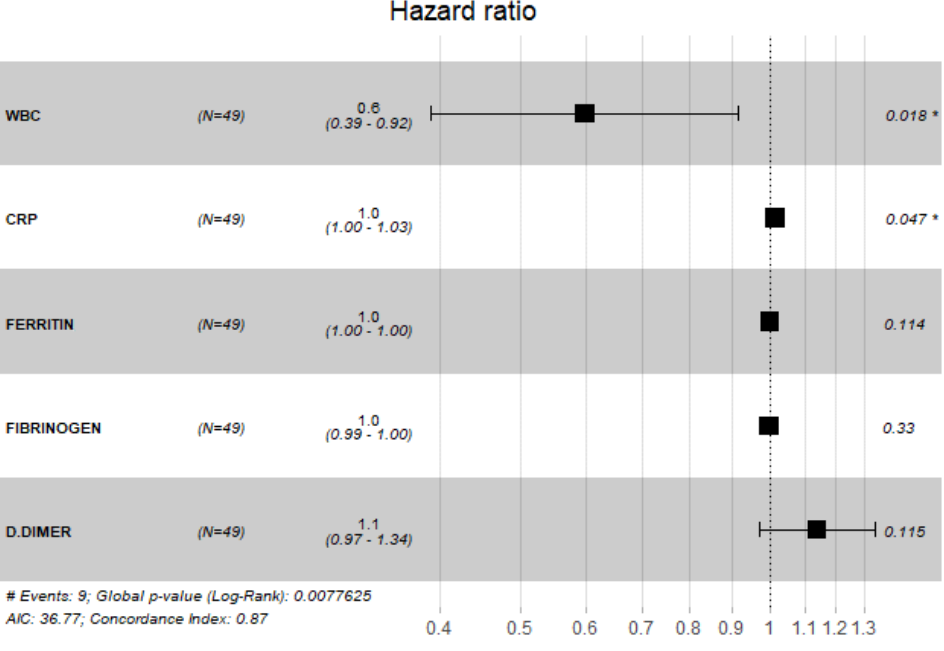
Figure 7. Cox proportional hazard model with laboratory